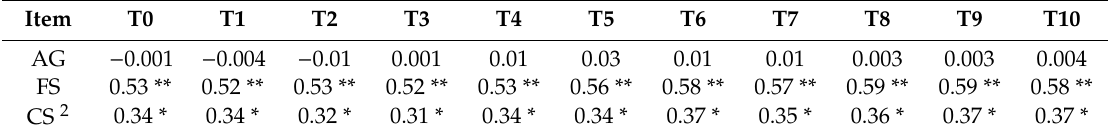
Table 3. Pearson’s correlation coe ffi cients between rectal temperature and agitometer score (AG 1 ), flight speed(FS 1 , m / s), andcrushscore(CS)betweenthetimeofweighing(T0)and10minpost-weighing(T10).